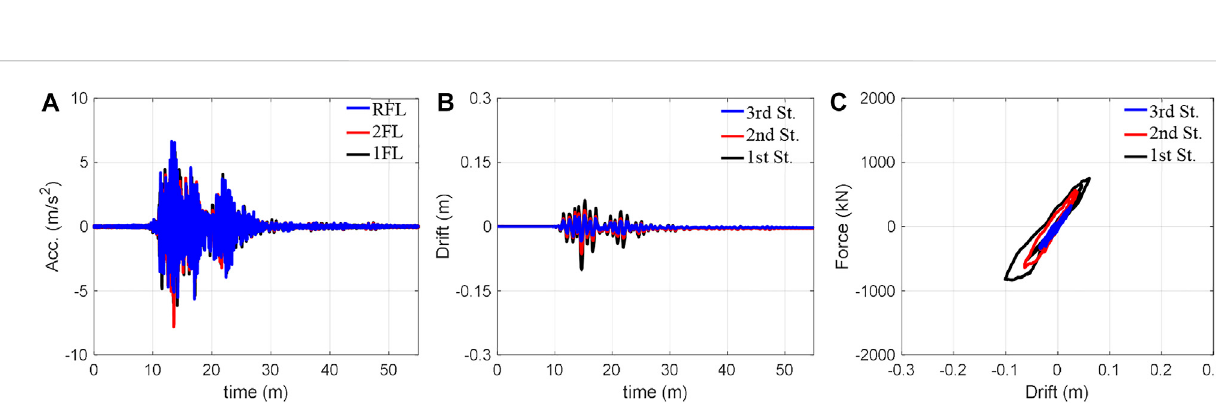
FIGURE 8 Responses of 60% Takatori: (A) acceleration, (B) inter-storey drift, and (C) hysteretic